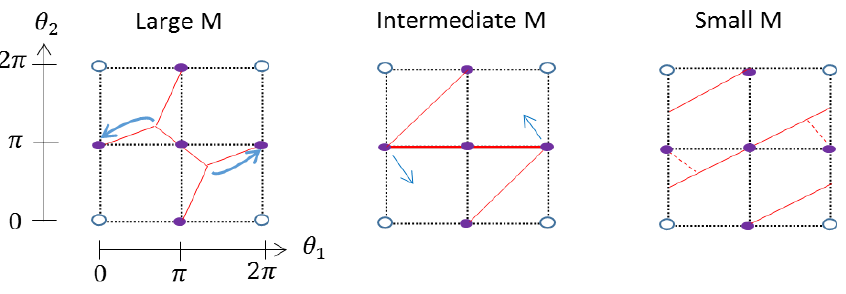
Figure 8 . An example of the expected (cid:13)ow from large M to small M for n 1 = 1, n 2 = 2. The empty circles represent the points at which T is preserved in the vacuum. The purple circles represent the points at which T is spontaneously broken. The blue arrows indicate the direction in which the intersection points move as we decrease M . As we see, there must be some intermediate M for which there is a point with fourfold degeneracy. The dashed lines disappear when M = 0. The phase diagram of the massless theory already presents us with an interesting